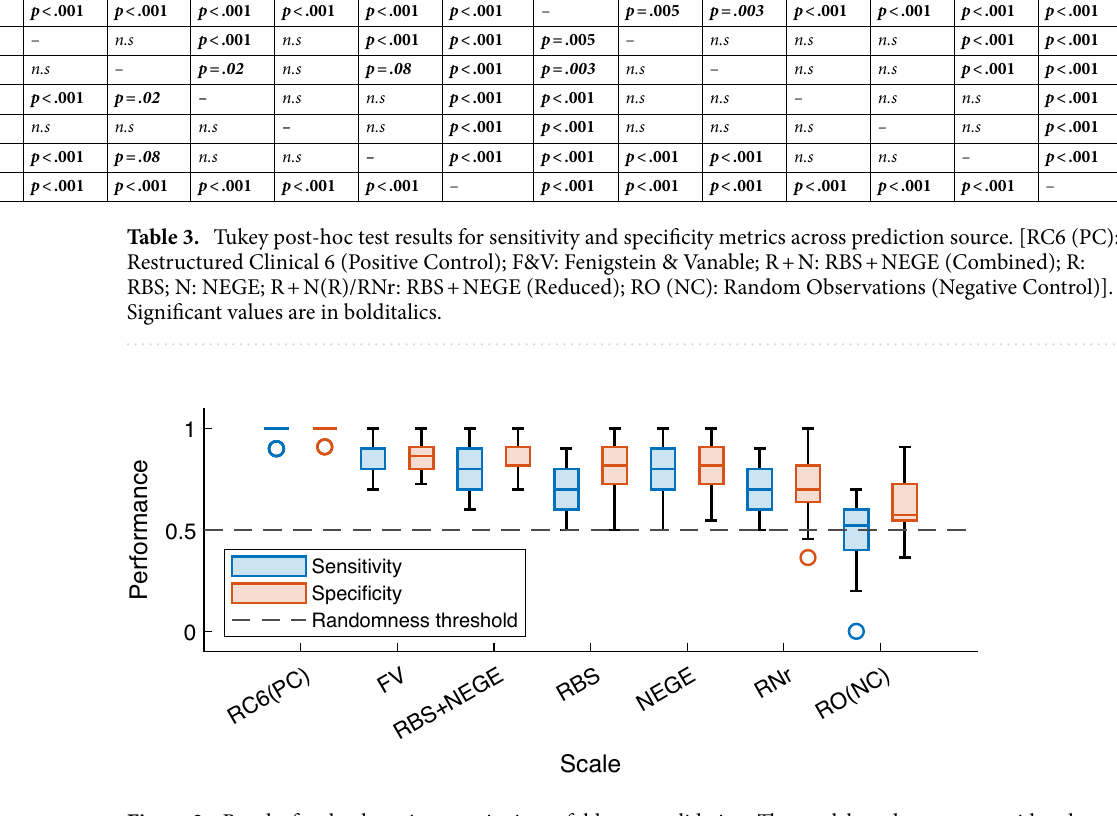
Figure 3. Results for the detection metrics in tenfold cross-validation. The model used was not considered as a variable given the absence of interaction of this variable with the other. [RC6 (PC): Restructured Clinical